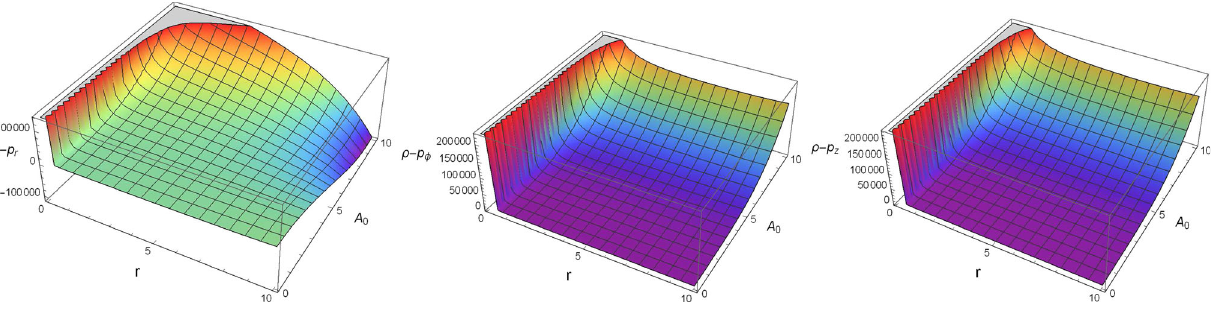
Fig. 16 This panel shows the behavior of (ρ − p r ) (MeV/fm 3 ) , (ρ − p φ ) (MeV/fm 3 ) and (ρ − p z ) (MeV/fm 3 ) w.r.t r (km) with m = n = 1 and α = − 0 . 01. CASE